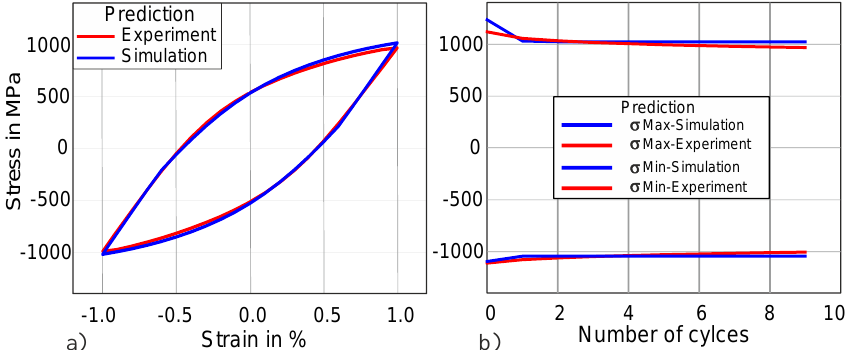
Figure 9. Validation of the method at higher force amplitudes: ( a ) predicted force – displacement at 75 N; ( b ) predicted force – displacement at 100 N.